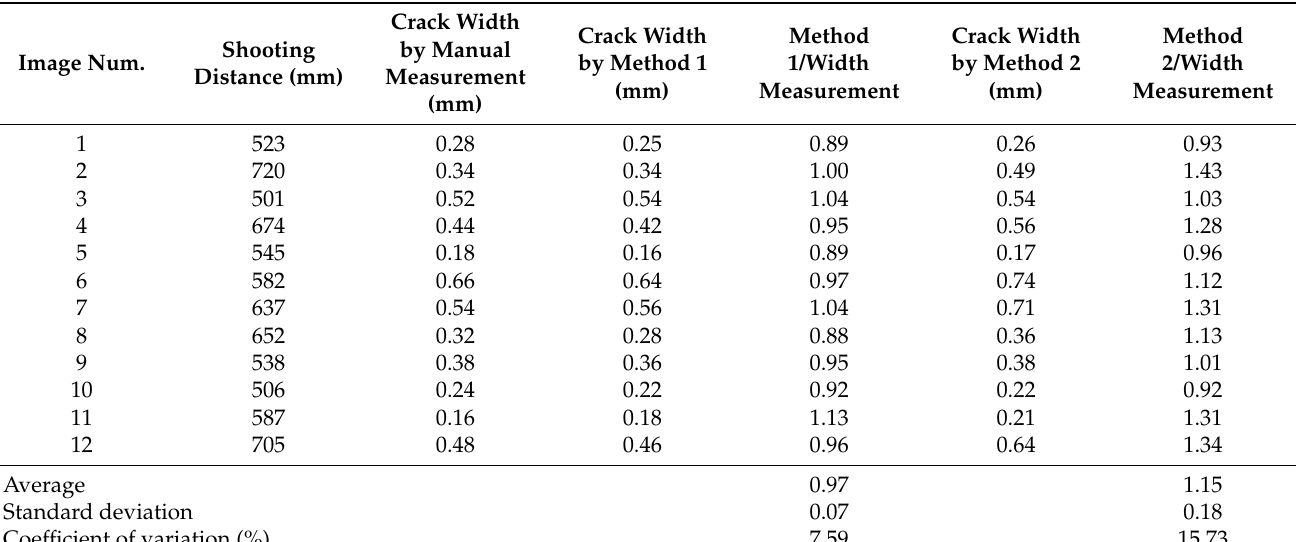
Figure 12. Crack images of the digital display crack width measurements. Table 1. Crack width results obtained by manual measurement and the UAV crack identification system.